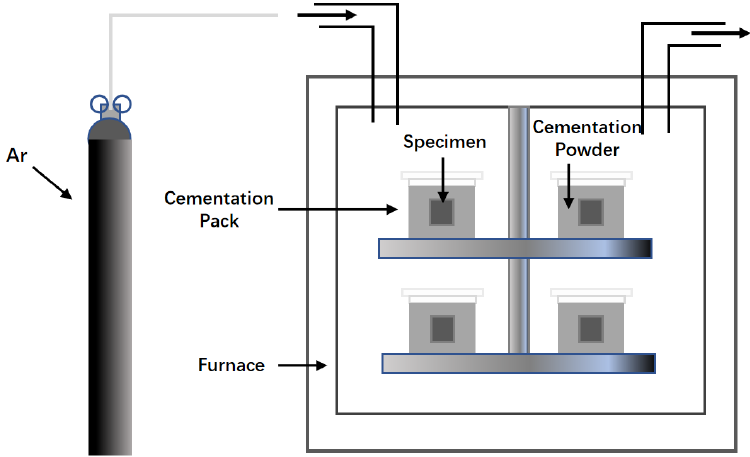
Figure 7. Process flowchart of HAPC method. Table 3. Summary for preparation and oxidation resistance of HAPC coatings on Nb-based alloys. Experimental Substrate